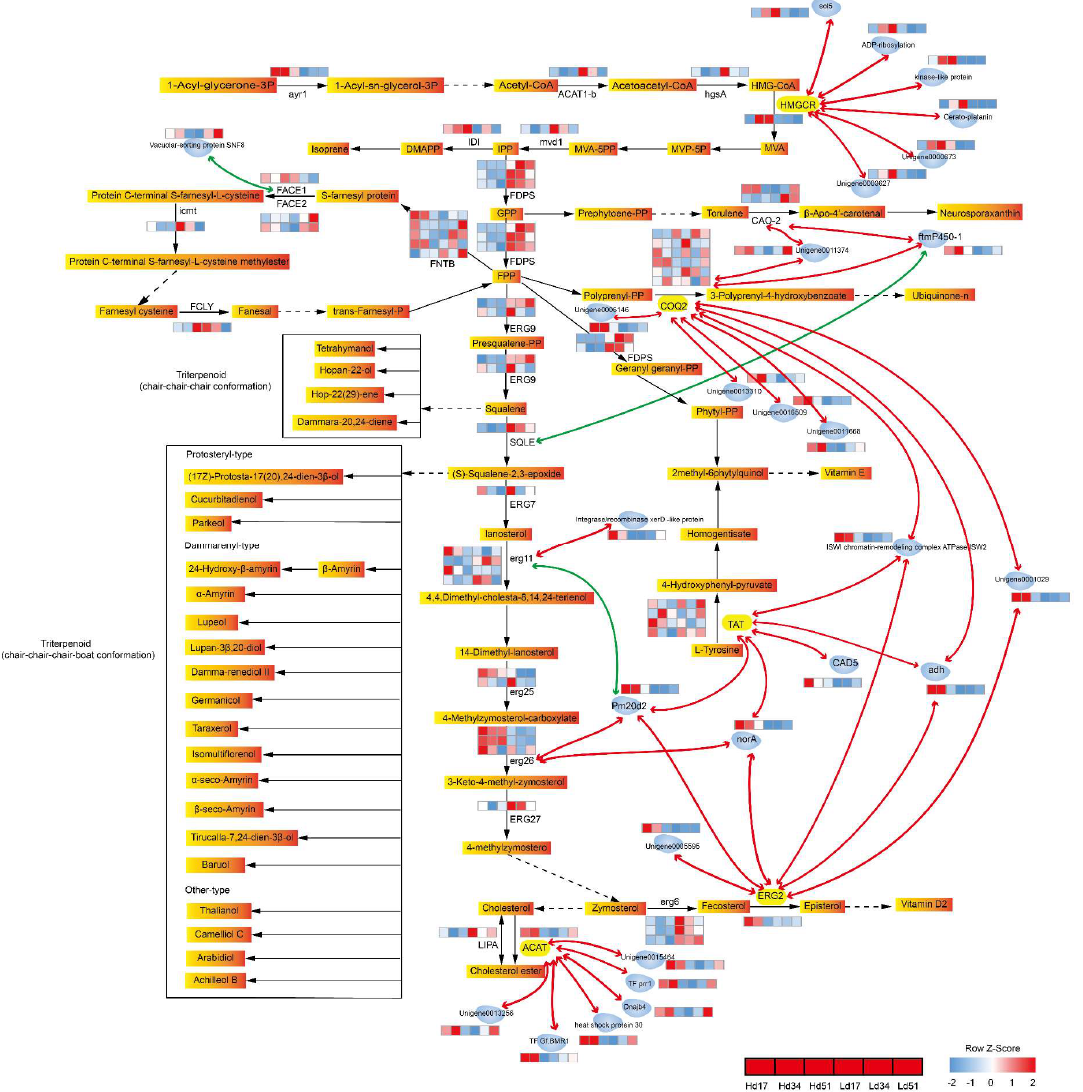
Figure 4. Gene expression differences and relational graph of triterpenoid-related genes. Gradual orange rectangles represent metabolite, enzyme abbreviation, and enzyme expression level of the three time points of the two strains marked on the bottom, left, or right of the arrow connecting two metabolites. Solid black arrows represent direct catalytic reactions, and dotted black arrows represent indirect catalytic reactions. Metabolites in solid black boxes are triterpene products of the same type catalyzed by different enzymes with the same precursor. Blue molecule shapes represent protein genes, marked with gene abbreviation or ID. Red lines represent positive correlation, green lines represent negative correlation, and line thickness represents the correlation coefficient r. The heat map of each gene’s reads per kilobase of transcript per million mapped reads (RPKM) value is z-score standardized.